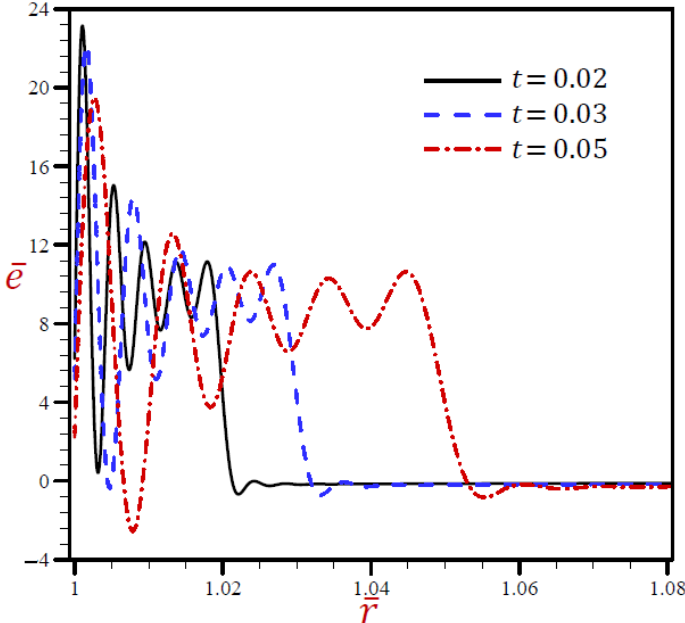
Figure 8. The influence of 𝑡 on volumetric strain 𝑒̅ through radial direction of spherical hole using RDPL model.